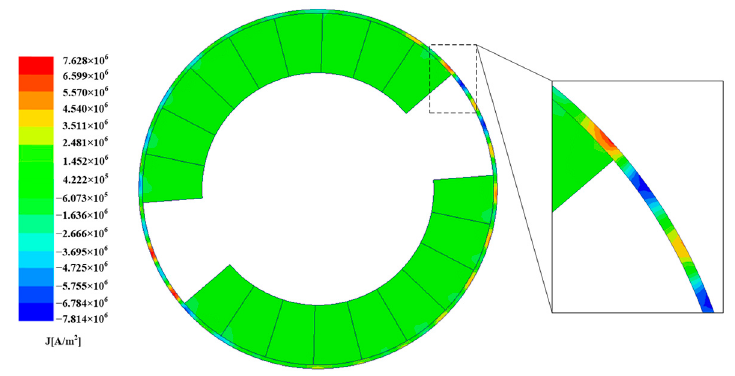
Figure 16. The eddy current density distribution of the 1 mm stainless steel jacket.